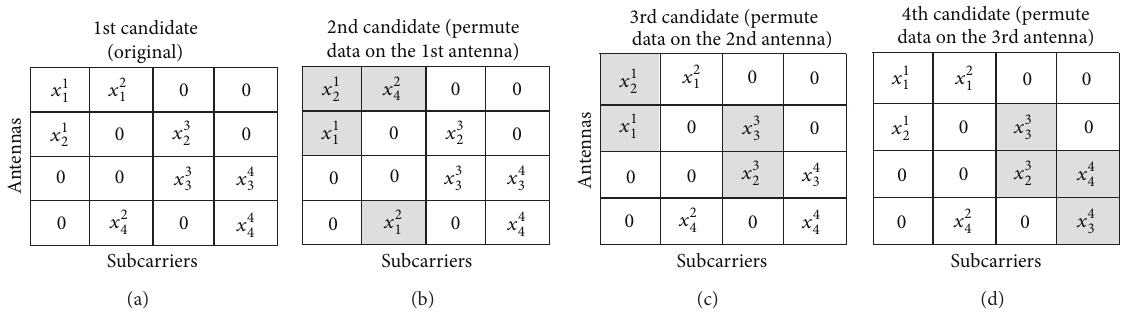
Figure 3: Illustration of cross-antenna permutations (𝑛 𝑇 = 4, 𝑛 𝐷 = 2 , and 𝐾 = 4)